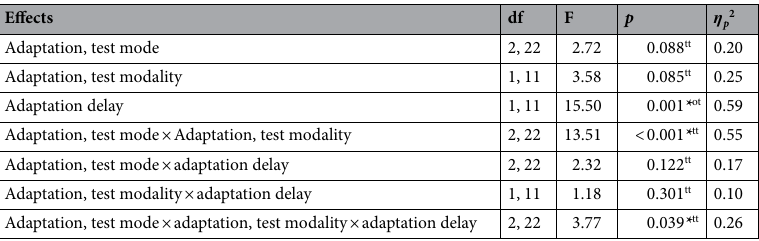
Table 2. Repeated-measures ANOVA results on detection thresholds within modalities. Bold asterisks indicate significant effects. ‘ ot ’ indicate one-tailed test values whereas ‘ tt ’ indicate two-tailed test values. df, degrees of freedom; F, F value, p , p value; ƞ p 2 partial eta-squared.